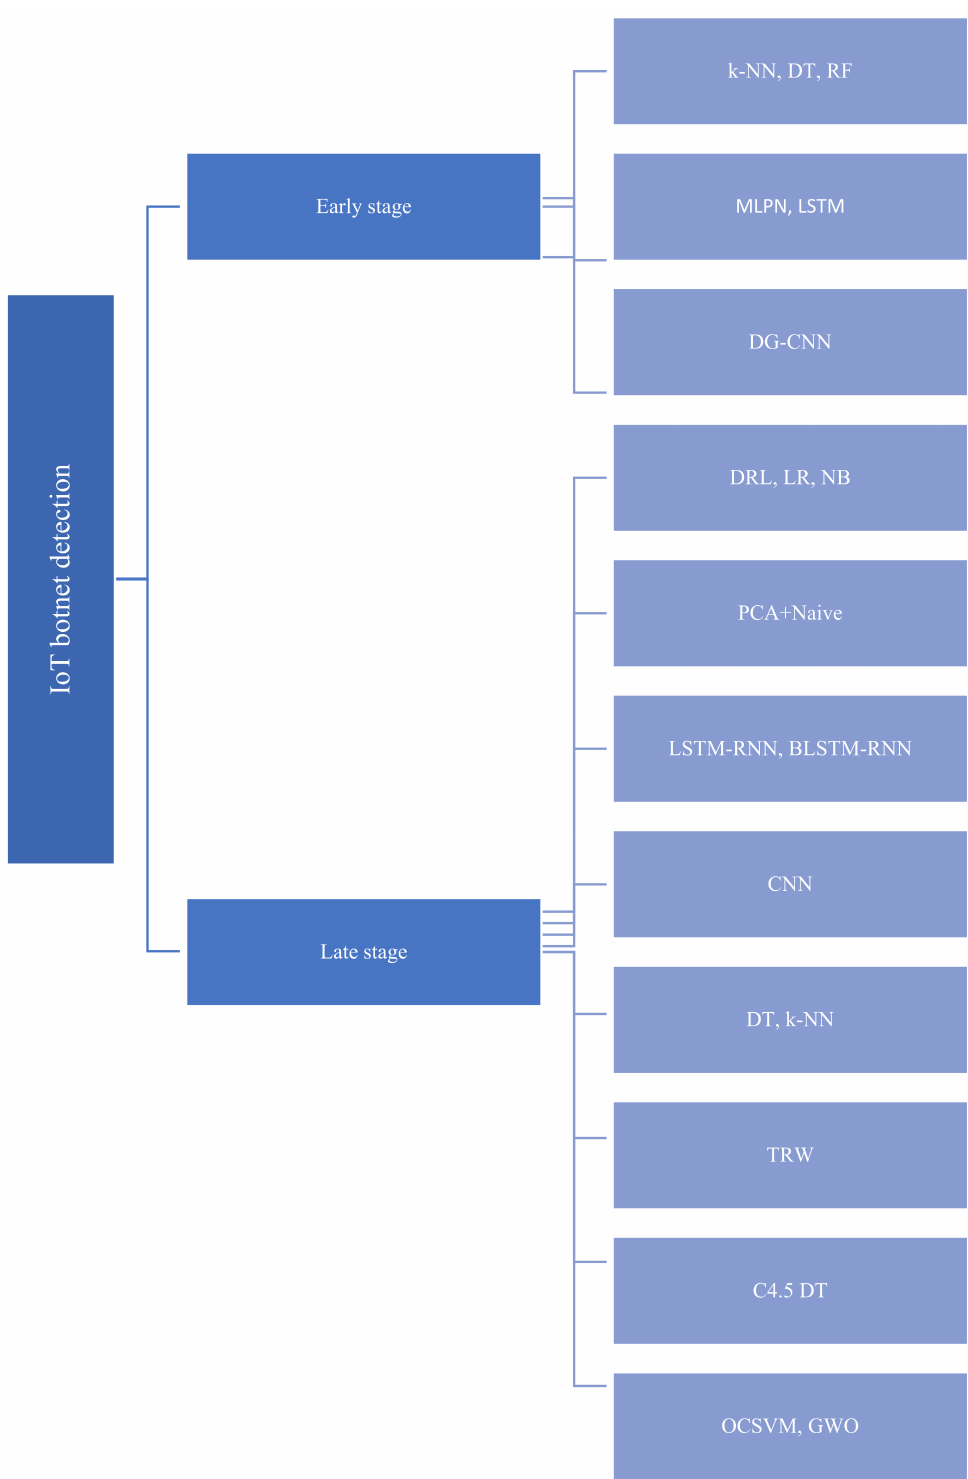
Figure 3. Taxonomy of state-of-the-art methods used to detect IoT botnets in early stage and late